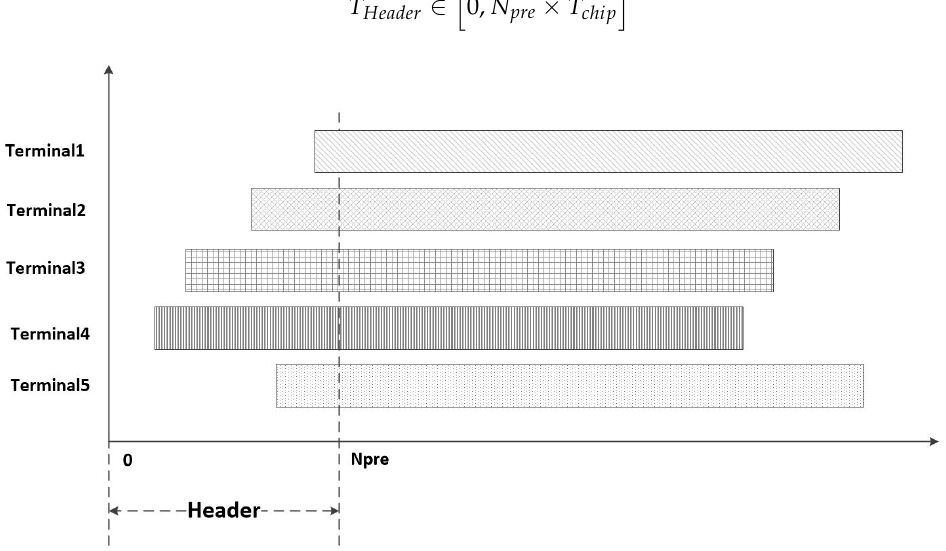
Figure 4. SSA access model.